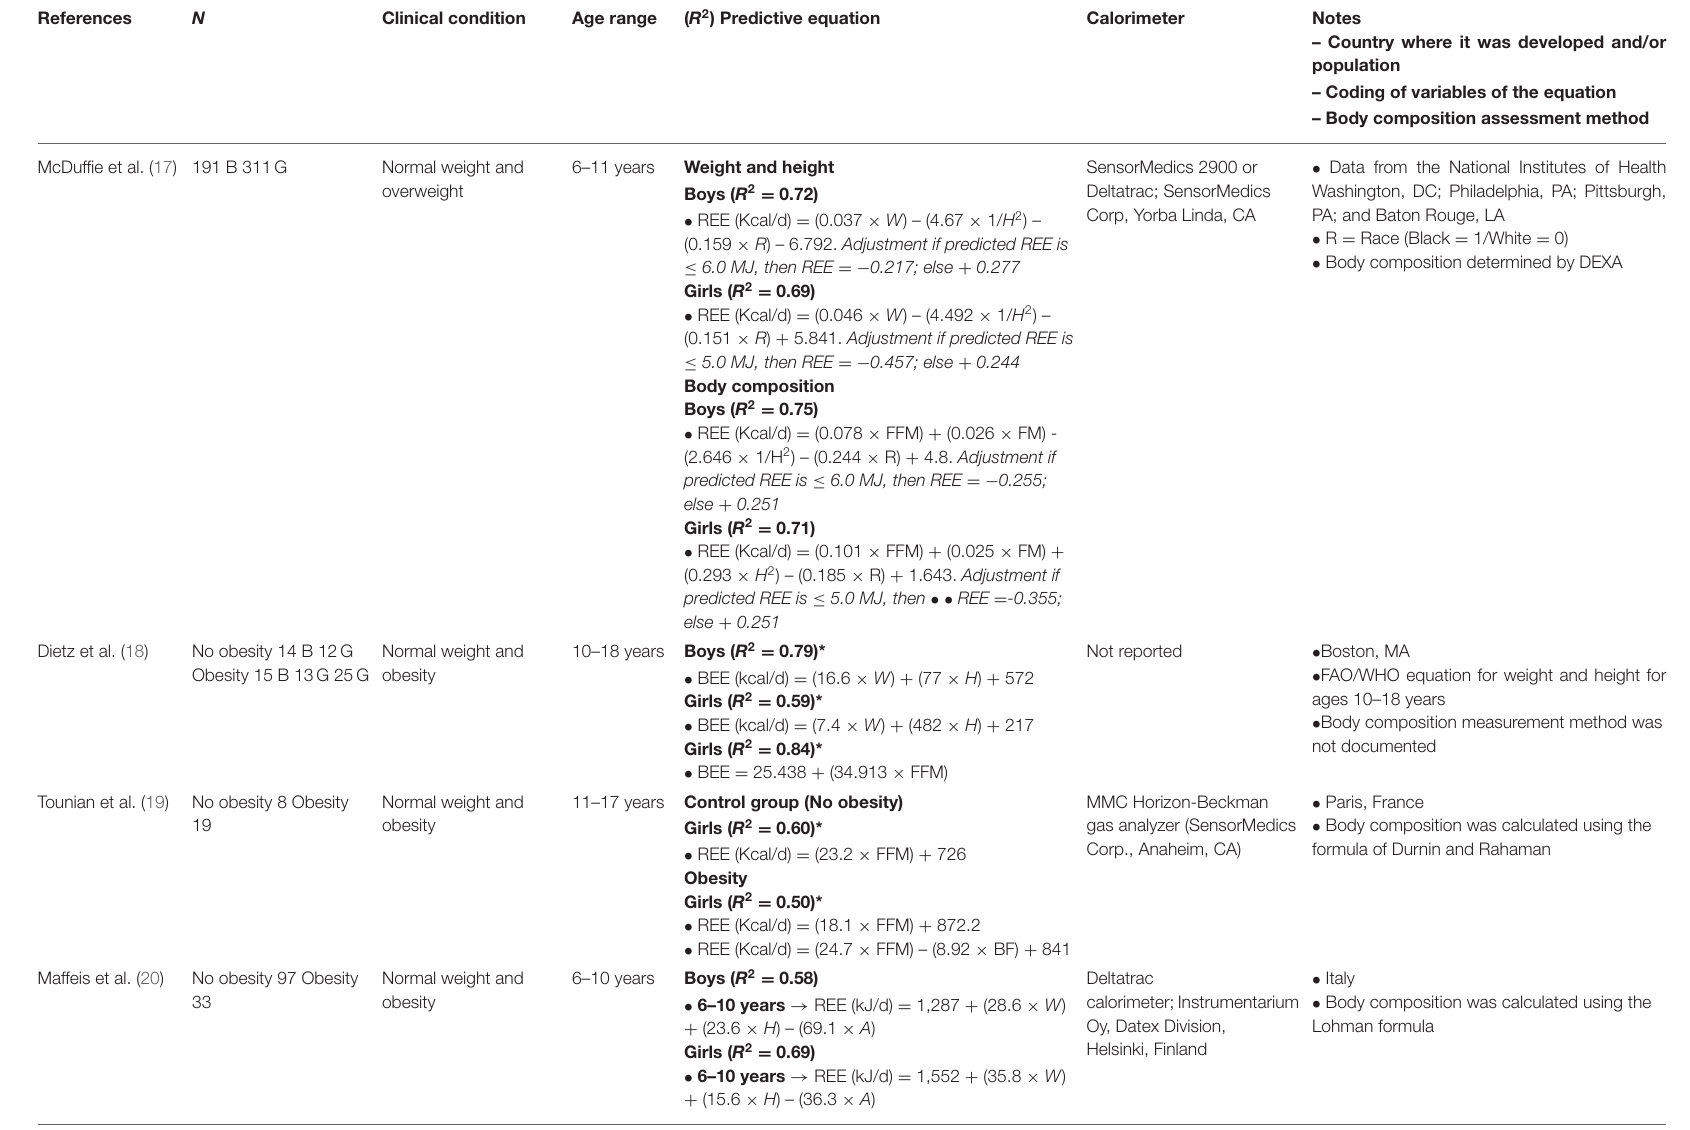
TABLE 3 | Equations for the prediction of energy expenditure in the pediatric population with overweight or